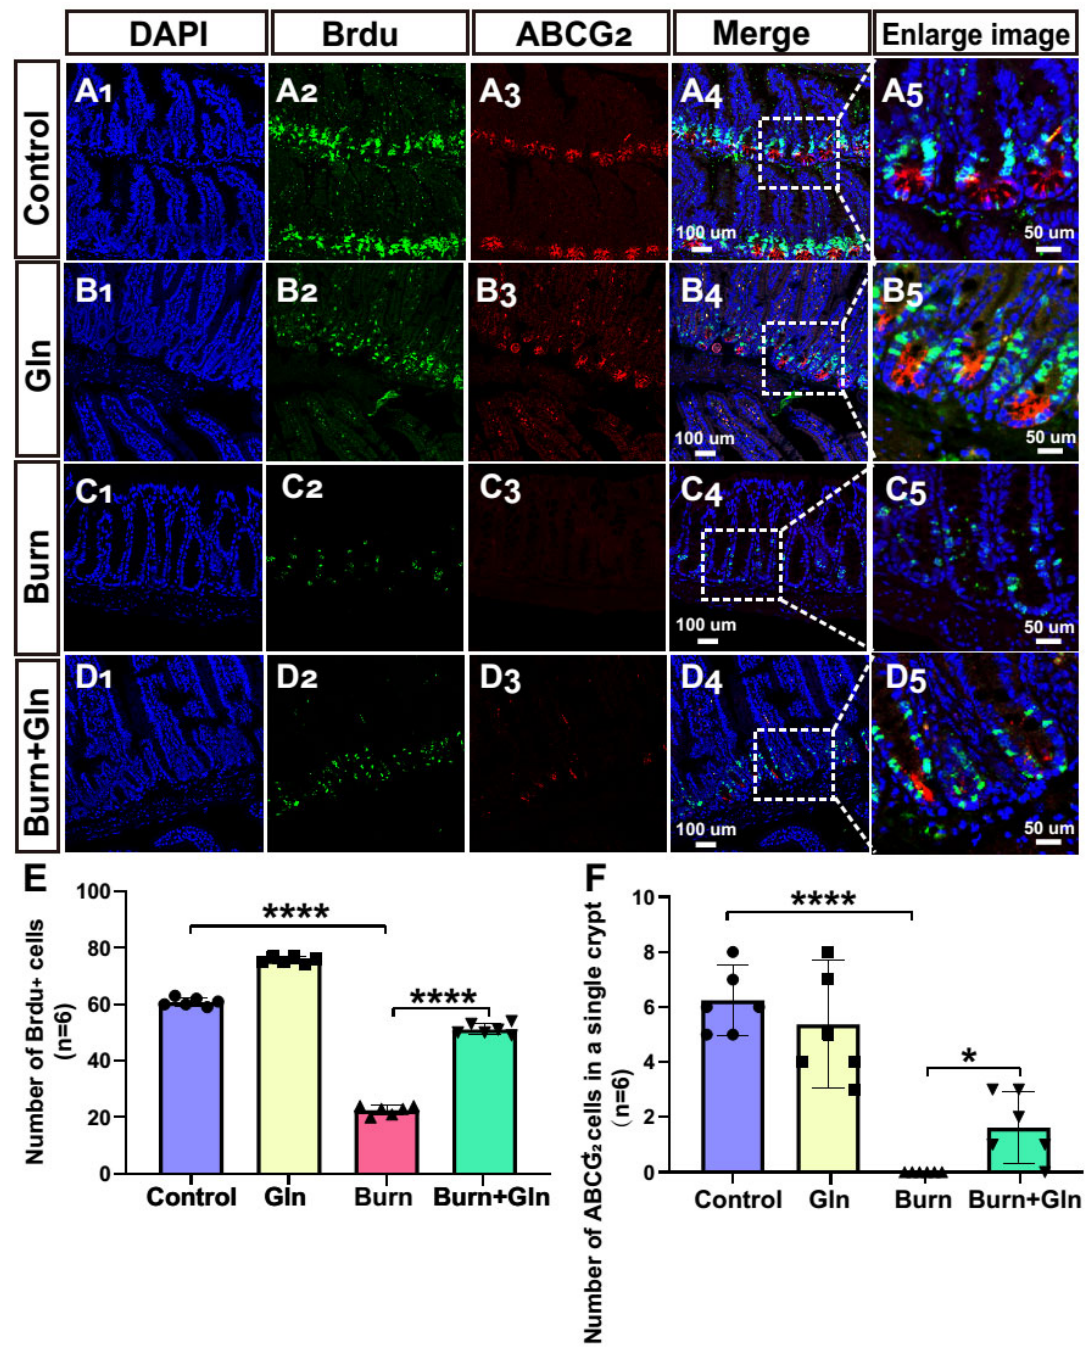
Figure 5. Gln treatment accelerates the small intestinal stem cell cycle and promotes the dry expression of ISCs C57 mice after burn injury. ( A – D ) Representative images of immunofluorescence for BrdU ( green ), ATP binding cassette subfamily G member 2 (ABCG 2 ) (red), and DAPI (blue) in different groups: ( A 1 – A 5 ) Control group. ( B 1 – B 5 ) Gln group. ( C 1 – C 5 ) burn group. ( D 1 – D 5 ) Burn+Gln group. ( E ) Comparison of the number of BrdU-positive cells in a single crypt in di ff erent groups ( n = 6). ( F ) Comparison of the number of ABCG 2 -positive cells in a single crypt in di ff erent groups. Data were expressed as mean ± SEM from 6 independent experiments ( n = 6). * p < 0.1, **** p < 0.0001 using 1-way ANOVA and post hoc Tukey’s test.